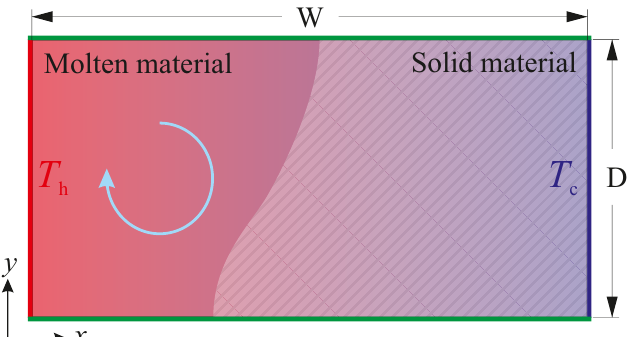
Figure 1. The schematic of the system under consideration. From t = 0, the left vertical wall is kept at an isothermal temperature T h , and the right vertical wall is kept at an isothermal temperature T c , whereas the horizontal walls are